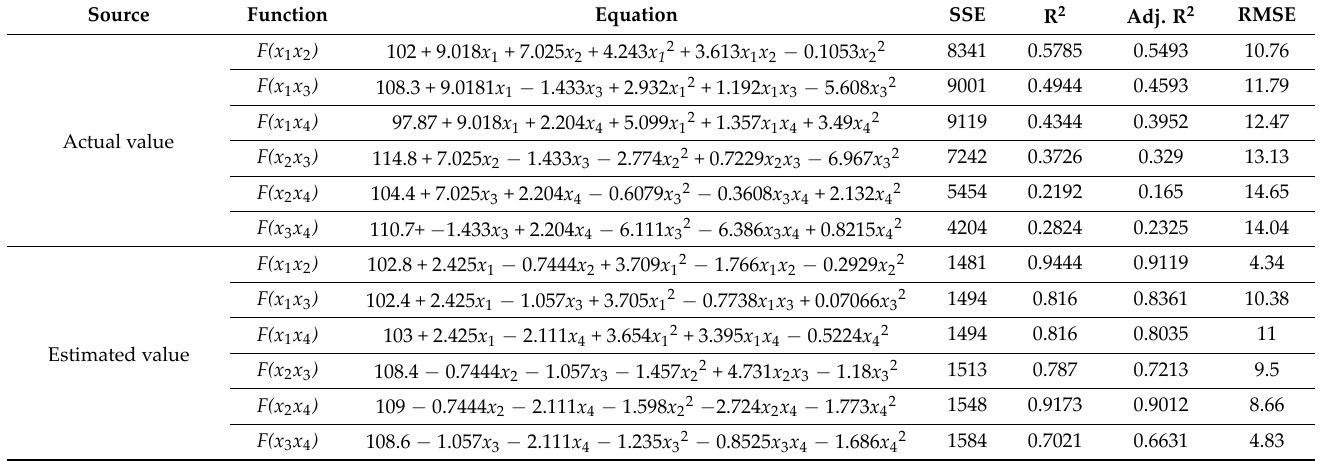
Table 5. The statistical criteria values of different interactions during the MLP